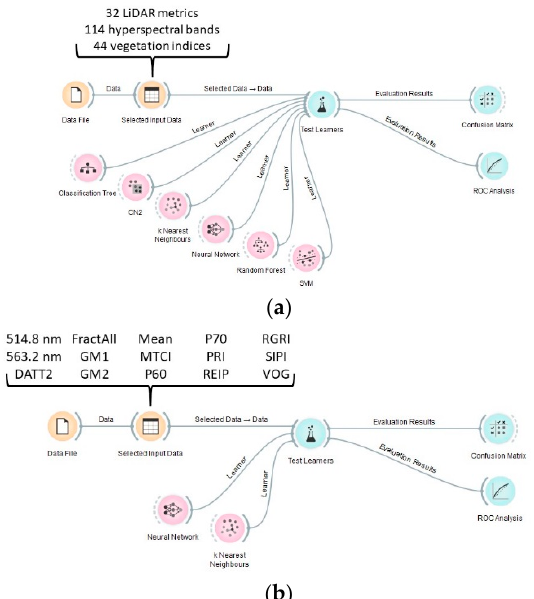
Figure 1. Sample Orange workflow for comparing machine learning methods. In the exploratory analysis step ( a ), all available machine learning methods were used in combination with the full suite of available data. In the simplified analysis ( b ), only the two best-performing machine learners were used on a simplified list of input variables, one example of which is shown here.